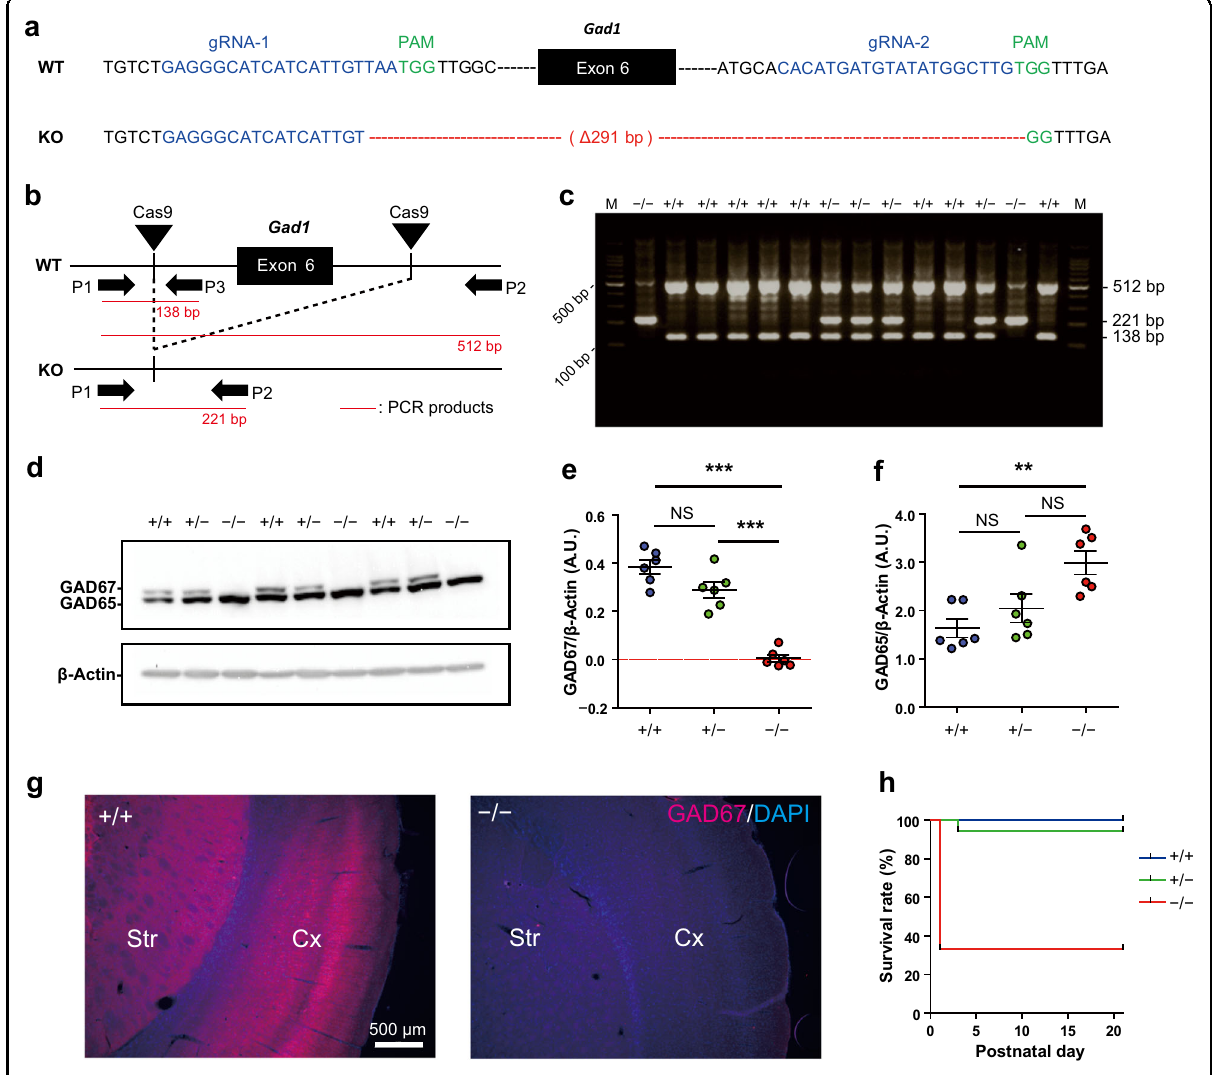
Fig. 1 Generation of Gad1 knockout rats by the CRISPR/Cas9 system. a Targeted site of Gad1 knockout rats. WT and KO represent wild-type and knockout alleles, respectively. The two sequences highlighted in blue denote the sites recognized by the complex of Cas9 and guide RNAs (gRNA-1 and gRNA-2). The protospacer adjacent motif (PAM) sequences next to the two sites are highlighted in green. The KO allele has a 291-bp deletion, including exon-6 of the Gad1 gene. b Schematic representation of CRISPR/Cas9-mediated deletion of exon-6 and the approximate locations of primers for genotyping PCR (P1, P2, and P3). c A representative result of genotyping PCR. M: DNA molecular weight marker. d Protein levels of GAD67 in the adult brain taken from each genotype ( n = 6 in each genotype). e Western blot analysis using an antibody that binds both GAD65 and GAD67 revealed the loss of GAD67 protein in Gad1 − / − rats ( F (2, 15) = 55.372, p <0.001). f GAD65 was increased in Gad1 − / − rats ( F (2, 15) = 8.0857, p <0.01). β -Actin was used as an internal control in d – f . g The loss of GAD67 immunoreactivity in the Gad1 − / − rat was also observed in the immunohistochemical analysis. Cx cerebral cortex, Sr striatum. The nuclei were stained using DAPI. Scale bar = 500 μ m. h Gad1 − / − rats showed a signi fi cantly lower survival rate than Gad1 + / + and Gad1 + / − rats (log-rank test, p <0.001). The data were analyzed using one-way ANOVA and post hoc test adjusted by Holm ’ s method for multiple comparisons ( e , f ) and log-rank test ( h ). The results are presented as the average ± SEM. * p <0.05, ** p <0.01, *** p